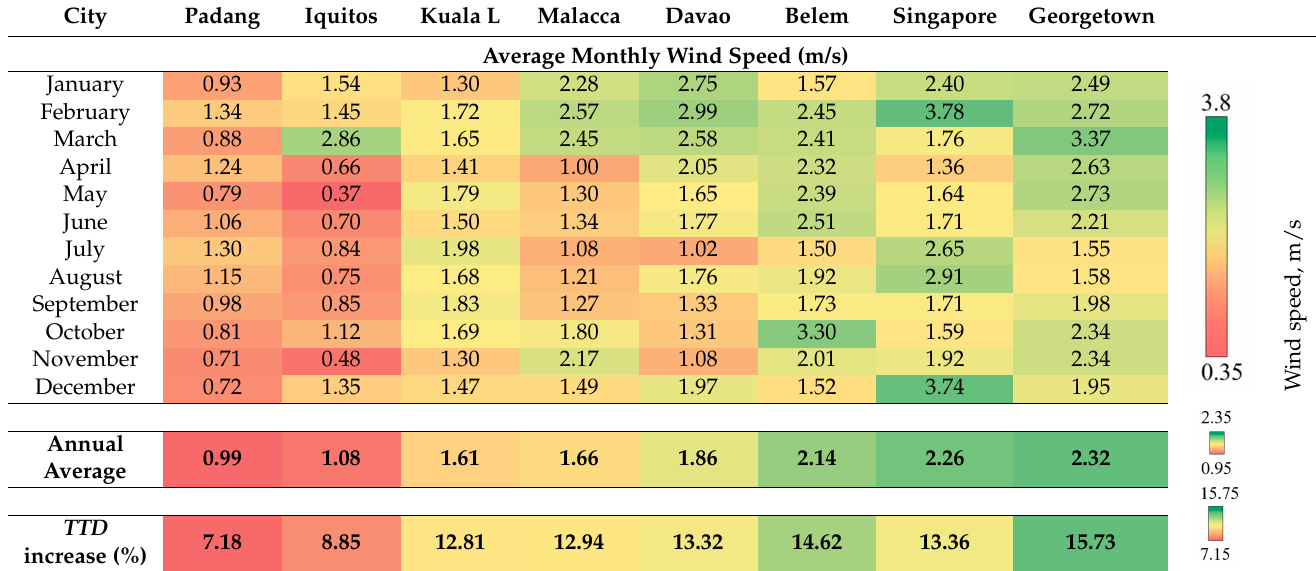
Table 5. Average monthly wind speed data and TTD increase values for all the cities.